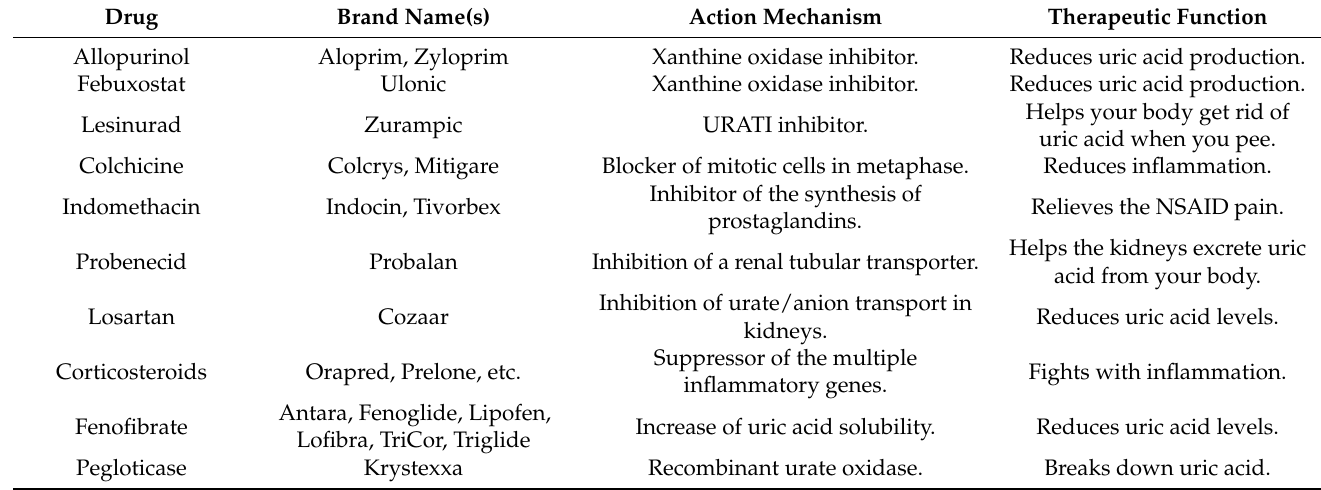
Table 1. Common medications for the treatments of hyperuricemia and gout